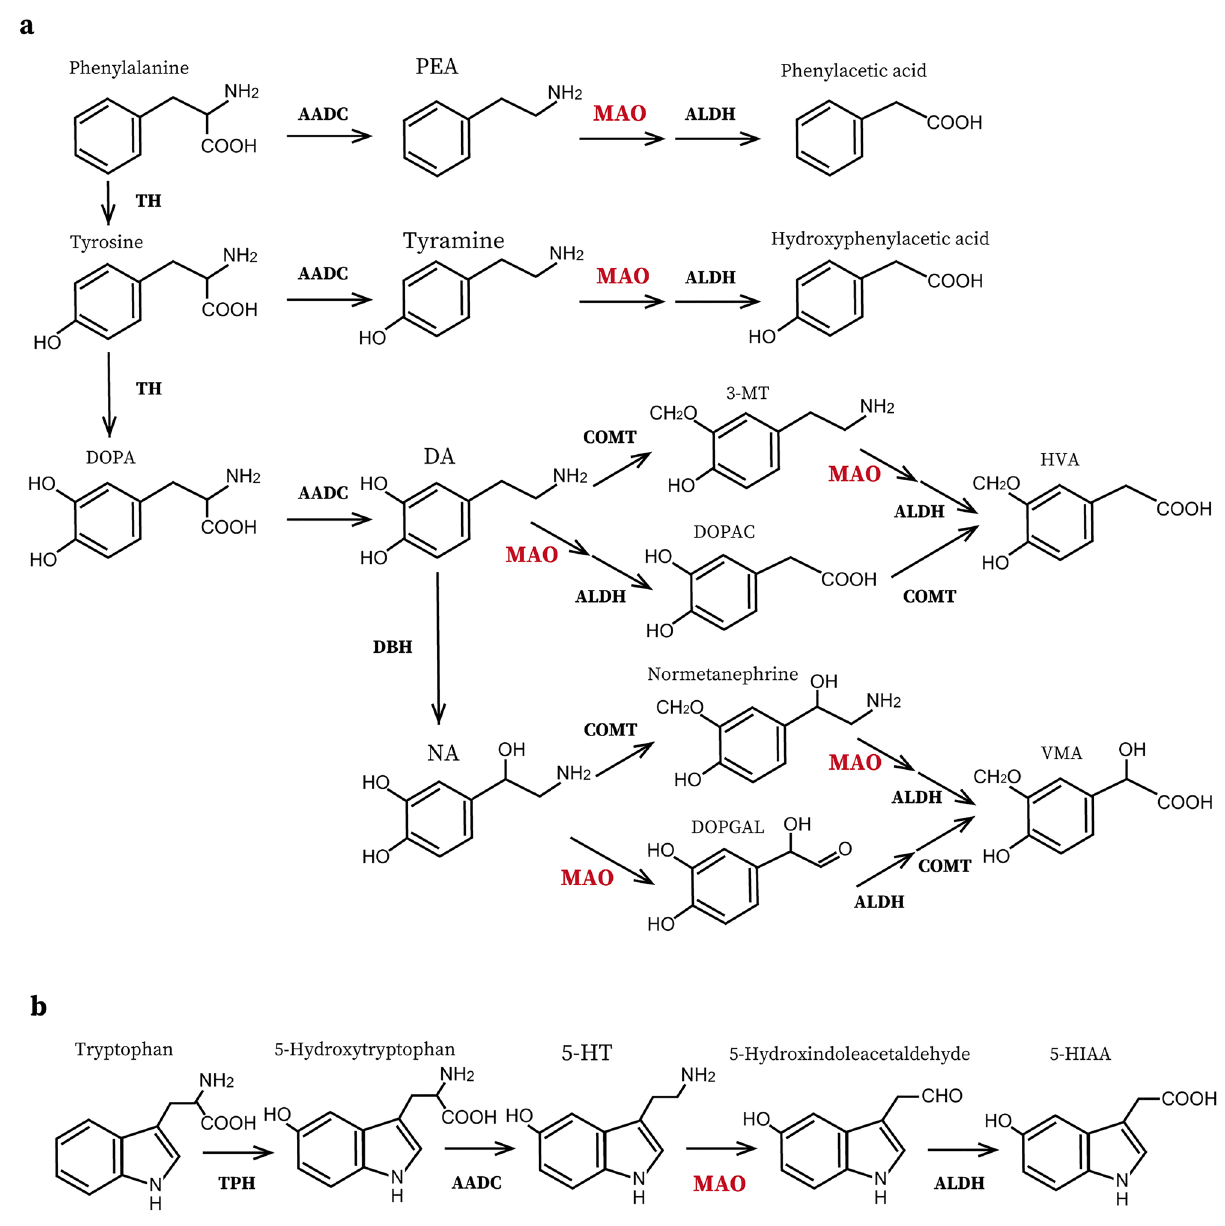
Figure 1. The MA metabolic pathways in the brain. ( a ) The synthetic and degradation pathways of phenethylamine (PEA), tyramine, dopamine (DA), and noradrenaline (NA). ( b ) The metabolic pathway of serotonin (5-HT). AADC aromatic l-amino acid decarboxylase, ALDH alcohol dehydroxylase, COMT catechol O -methyltransferase, DBH dopamine β-dehydroxylase, DOPAC 3,4-dihydroxyphenylacetic acid, DOPGAL 3,4-dihydroxyphenylglycolaldehyde, 5-HIAA 5-hydroxyindole acetic acid, HVA homovanillic acid, 3-MT 3-methoxytyramine, TH tyrosine hydroxylase, TPH tryptophan hydroxylase, VMA vanillylmandelic